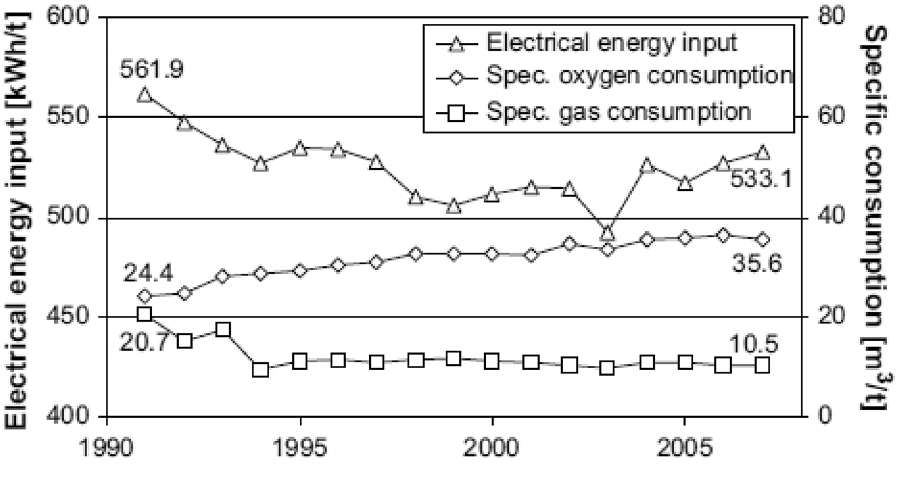
Fig. 8 Distribution of green- house gas (GHG) sources reductions for present conven- tional EAF for baseline process conditions